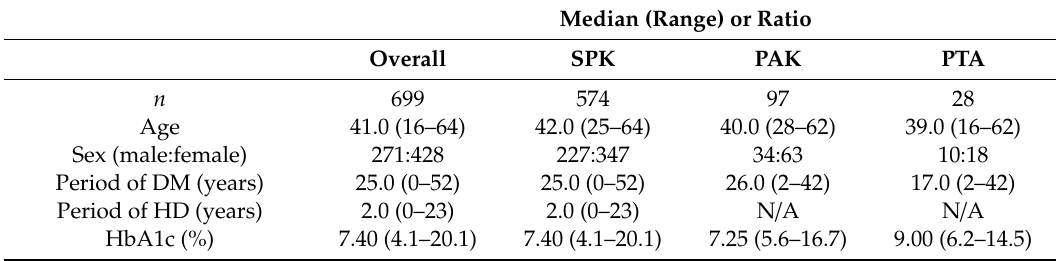
Table 1. Background characteristics of patients on the waiting list at the time of registration. Median (Range) or Ratio Overall SPK PAK PTA n 699